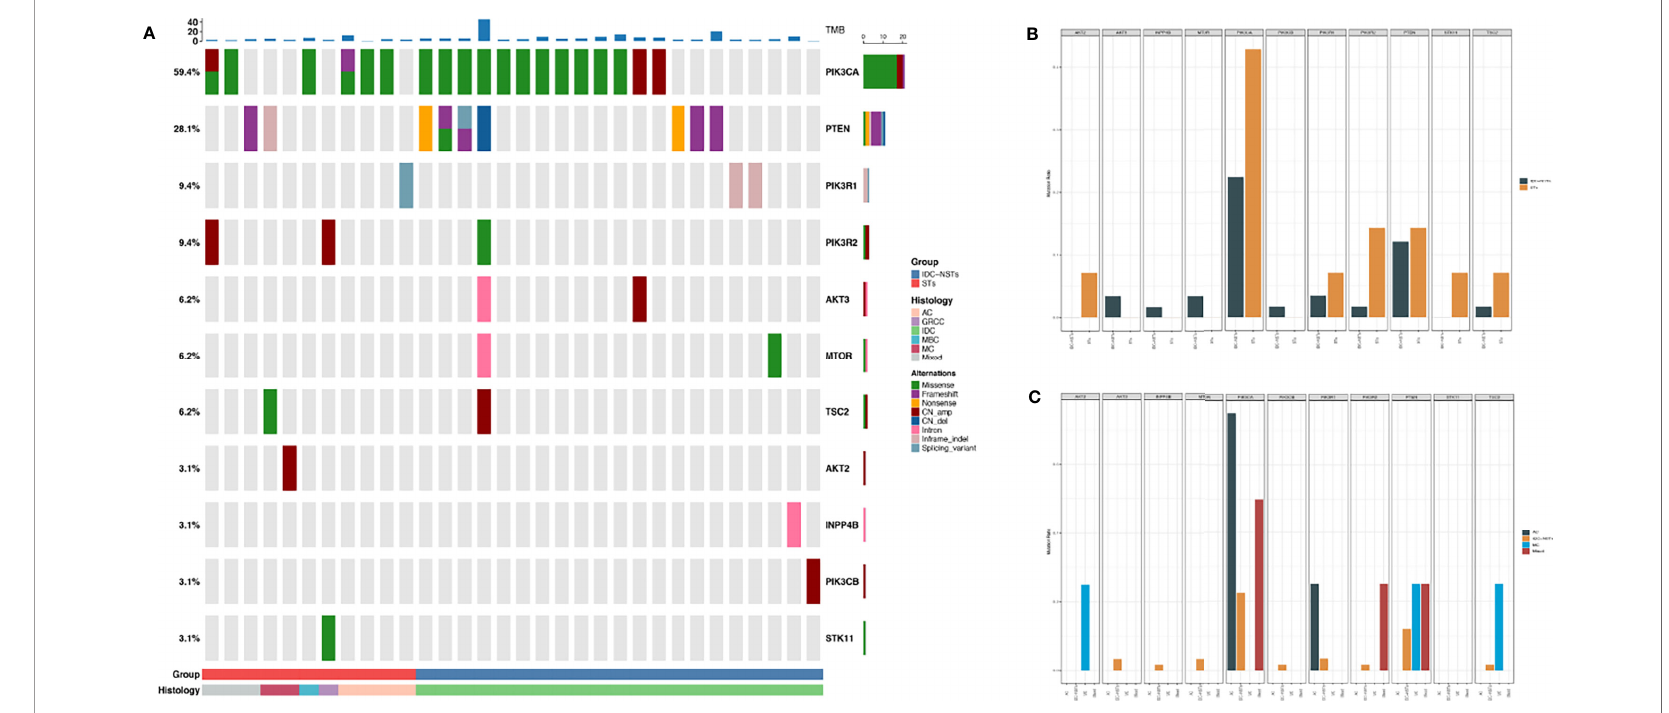
FIGURE 5 | Kyoto Encyclopedia of Genes and Genomes analysis reveals distinct pathways in NSTs and STs tumors of TNBC. In total, 36.2% of the NSTs patients and 78.6% of the STs patients had at least one clinically relevant genomic alteration in genes involved in the PI3K-AKT signaling pathways, respectively. (A) Summary of the features of the PI3K-AKT signaling pathways genomic alteration of the 32 patients with TNBC. Tumor samples were grouped according to histologic types as: no-special type (IDC-NSTs, n=21) and special type (STs, n=11). (B) Comparison of the features of the PI3K-AKT signaling pathways genomic alteration between NSTs and STs TNBC patients. (C) Comparison of the features of the PI3K-AKT signaling pathways genomic alteration among STs TNBC patients. TNBC, triple-negative breast cancer; NST, no-special type; ST, special type; TMB, tumor mutation